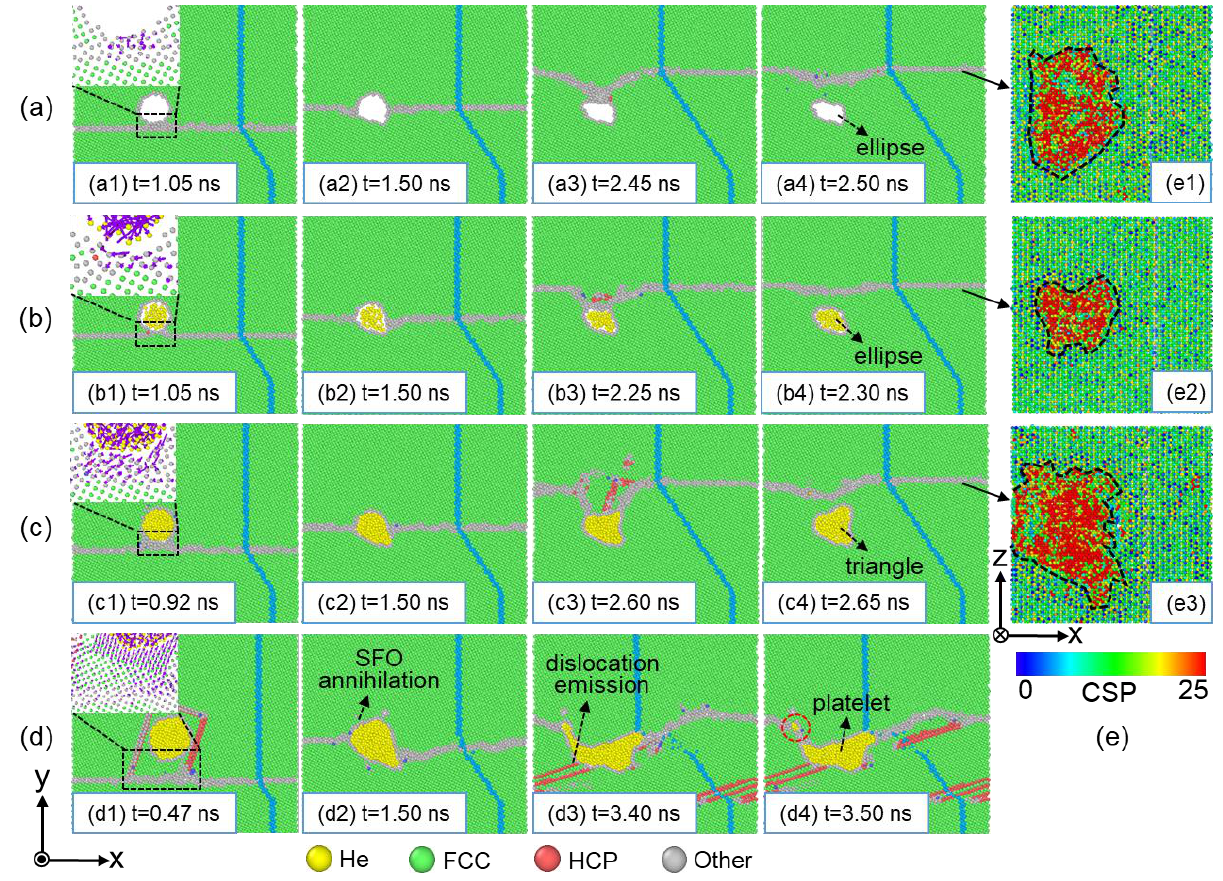
Figure 3. Cross-sectional view of the dynamic interaction between GB and He bubble for samples with different R He/V at T 0 = 300 K and D 0 = 2 nm. ( a ) R He/V = 0; ( b ) R He/V = 0.5; ( c ) R He/V = 2.0; ( d ) R He/V =5.0; ( e ) GB structure after interaction, colored by Centro-symmetry parameter (CSP). The blue atomic lines indicate the shear deformation.